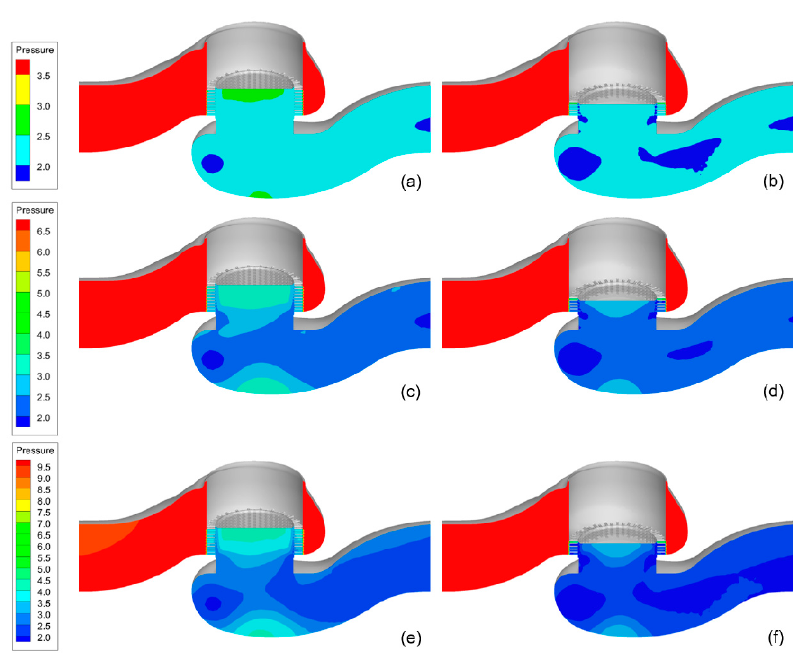
Figure 6. Pressure contours inside the sleeve regulating valve with valve core displacement of 60 mm and 30 mm (MPa) ( a ) 2 MPa, 60 mm; ( b ) 2 MPa, 30 mm; ( c ) 5 MPa, 60 mm; ( d ) 5 MPa, 30 mm; ( e ) 8 MPa, 60 mm; ( f ) 8 MPa, 30mm.